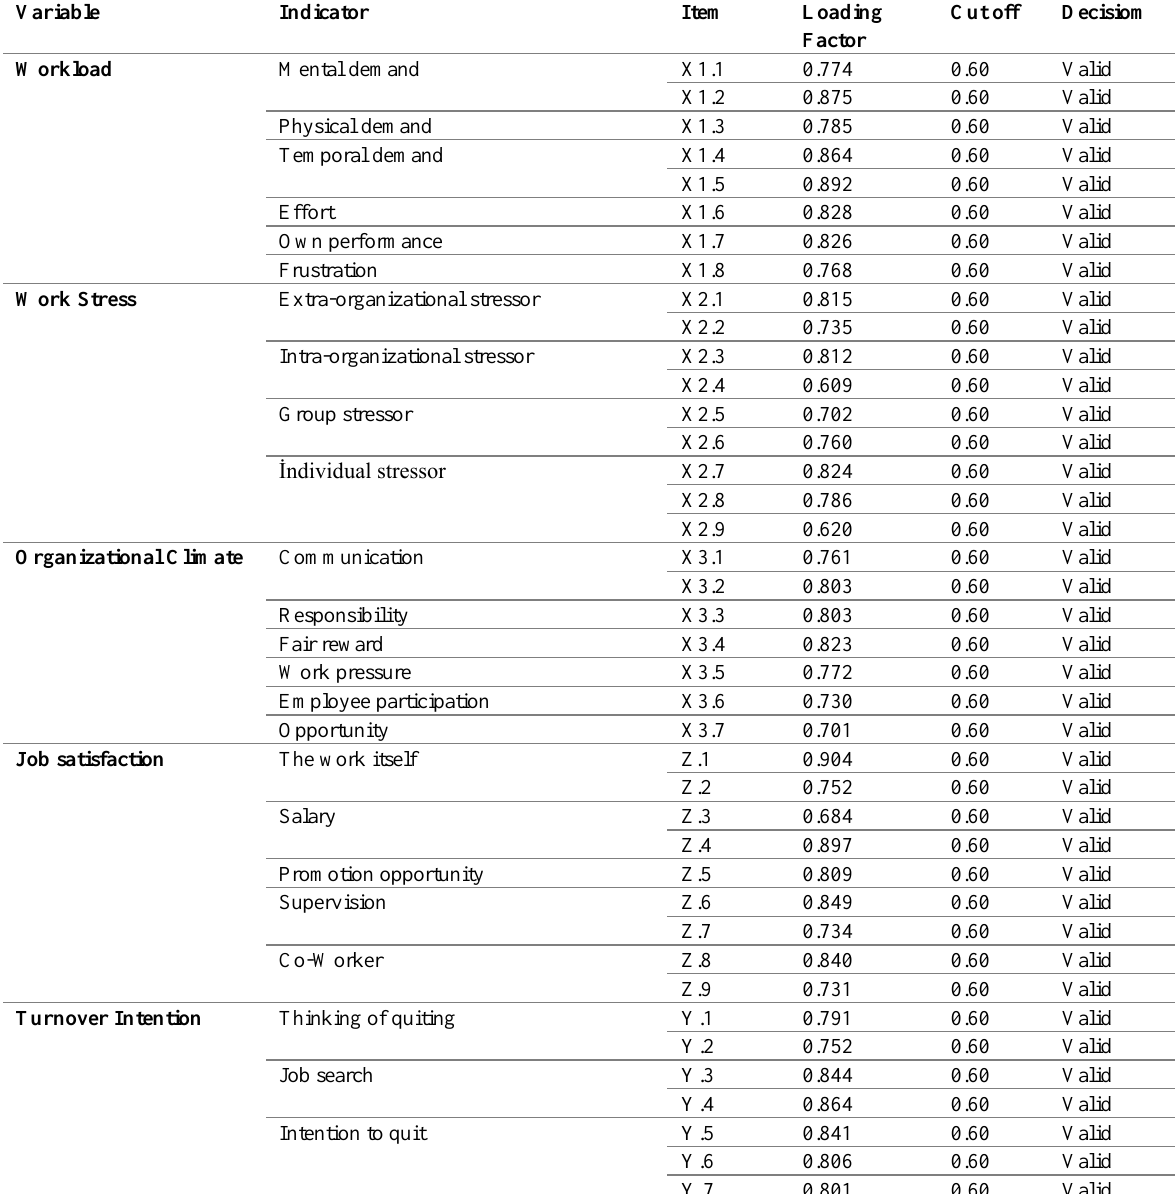
Table 2: Results of Convergent